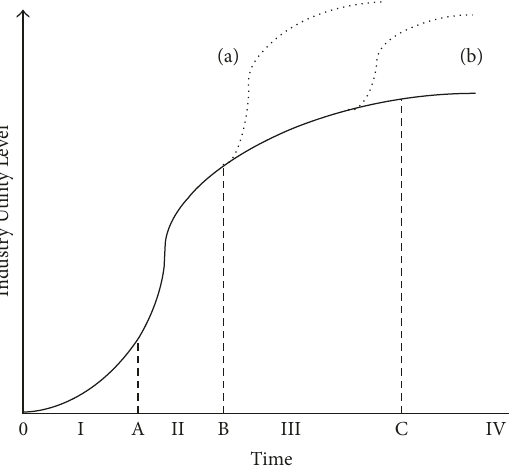
Figure 2: Industry life cycle with innovation.